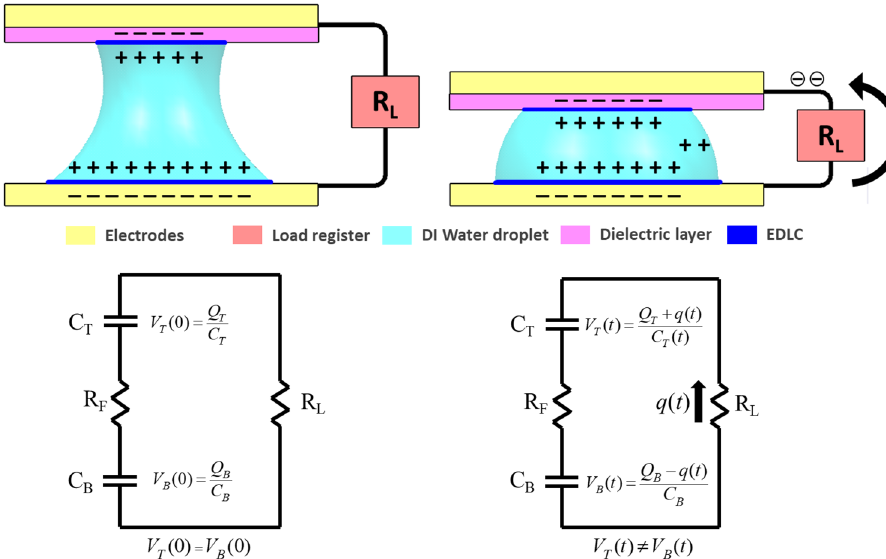
Figure 5. Schematics of RC-circuit model with